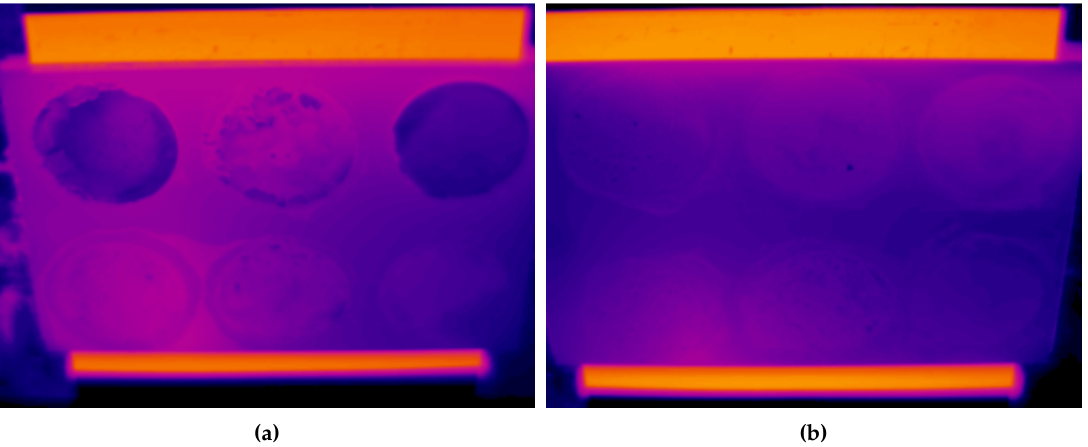
Figure 10. Infrared images acquired for the evaluation of dust detection. ( a ) Reflector polluted with 5g; ( b ) reflector polluted with 0.5g. From left to right and from top to bottom: ash, red soil, cement, limestone, coarse sand and fine